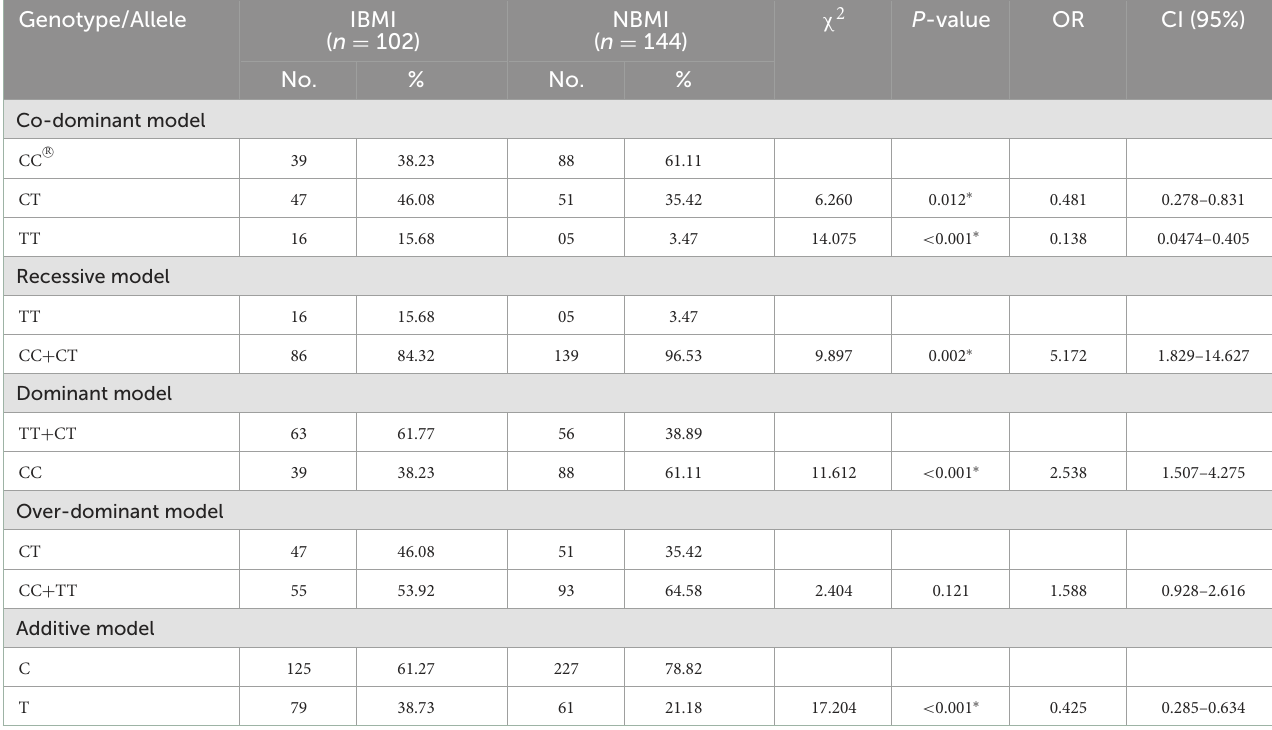
TABLE 5 BDNF gene polymorphism under co-dominant, recessive, dominant, over-dominant, and additive models in individuals with increased BMI (IBMI) and normal BMI (NBMI).